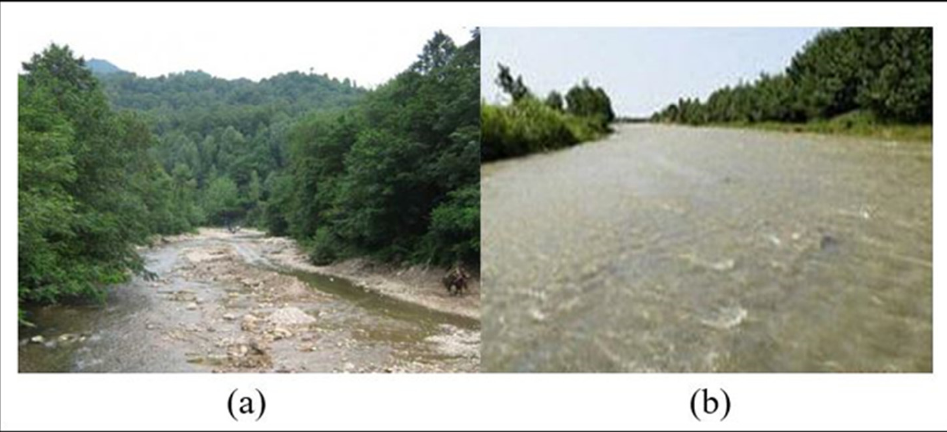
shown as an example in Figure 4.